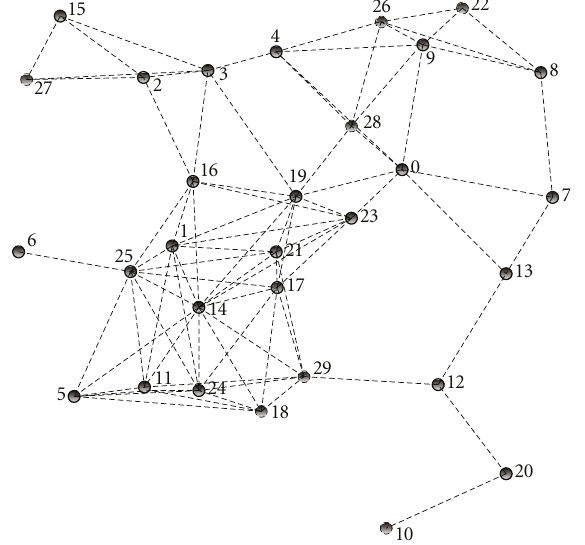
Figure 6: Random wireless network with 30 nodes.